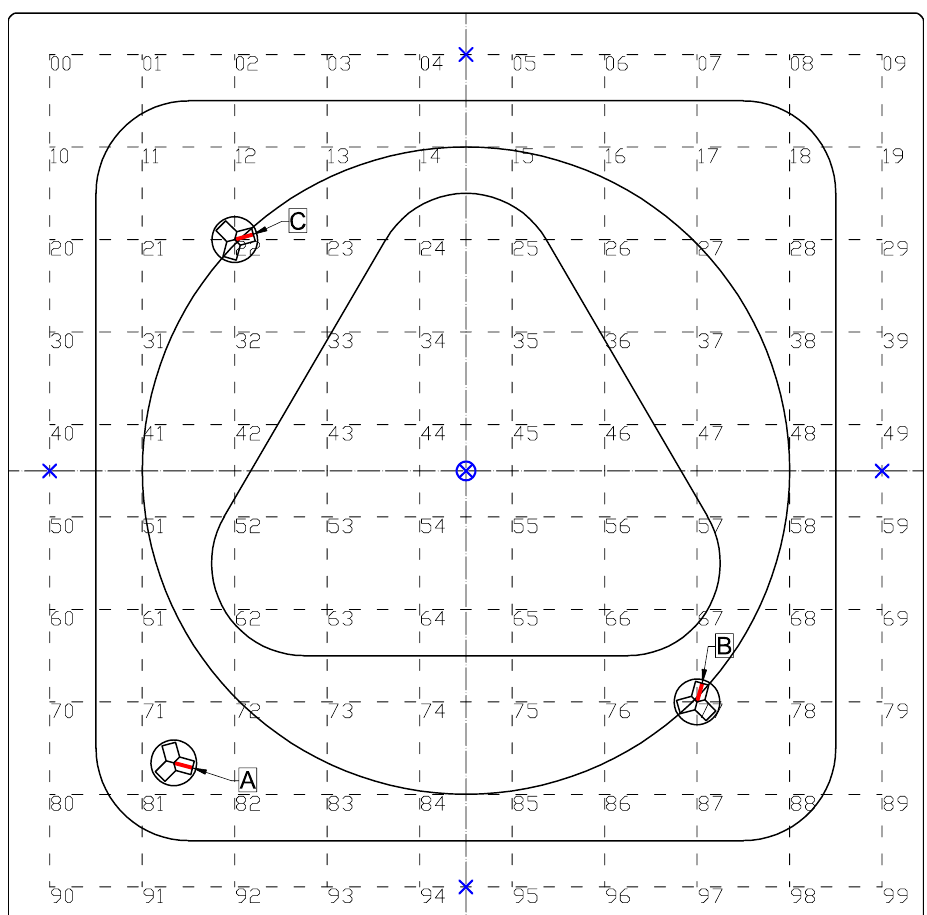
Figure 3. Scheme of the plate: placement of the strain sensors (A, B, and C) on the bottom face, supports ( × pin support, ⊗ fixed support), and spatial discretization into a 10 × 10 point